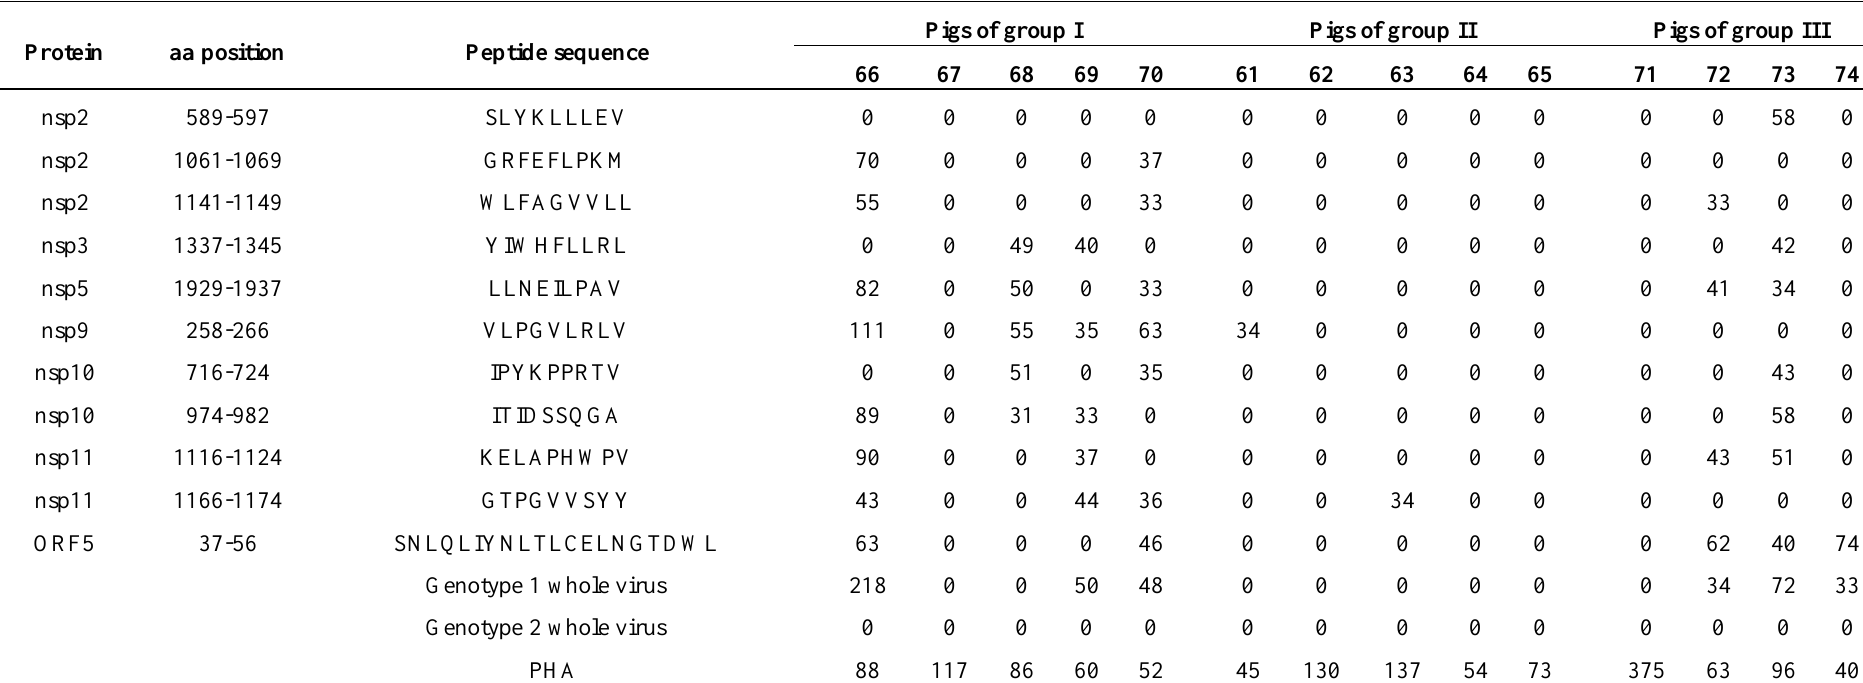
Table 4. IL-10 levels (pg/mL) as determined by ELISA in cell culture supernatants of PBMC of PRRSV-vaccinated and unvaccinated pigs after stimulation with different peptides (10 µg/mL) of non-structural proteins of PRRSV. The table only shows peptides inducing IL-10 release in PBMC cultures of at least one